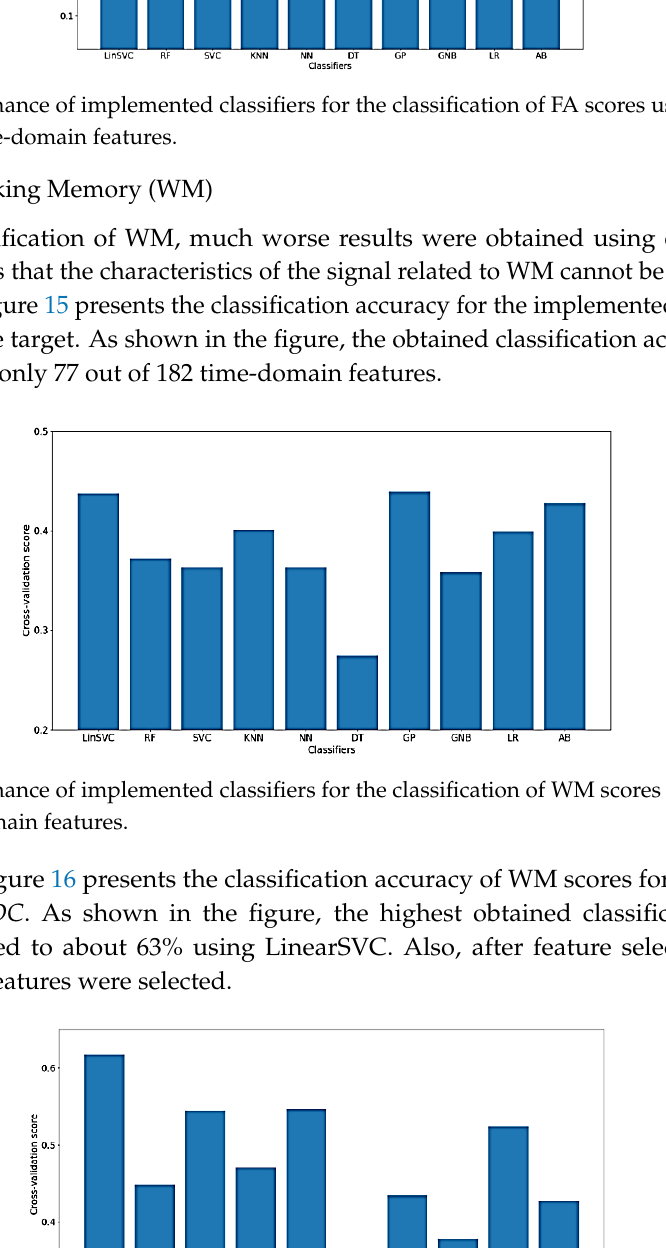
Figure 16. Performance of selected classifiers for the classification of WM scores using NoDC data and only time-domain features.